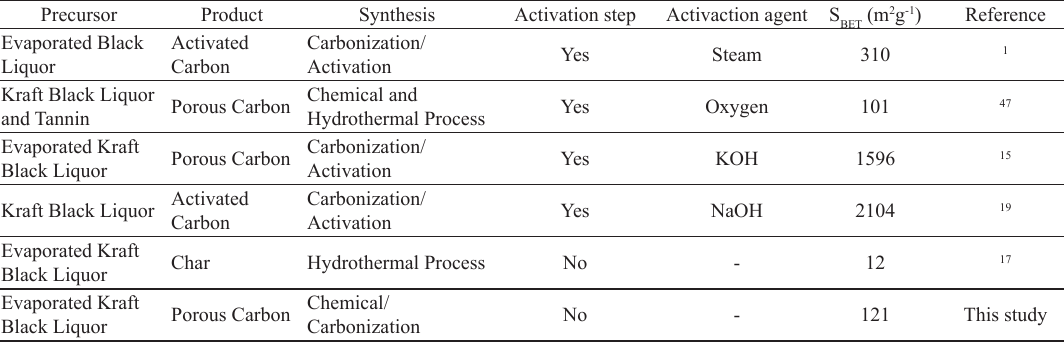
Table 2. Properties of porous carbon derived from black liquor.